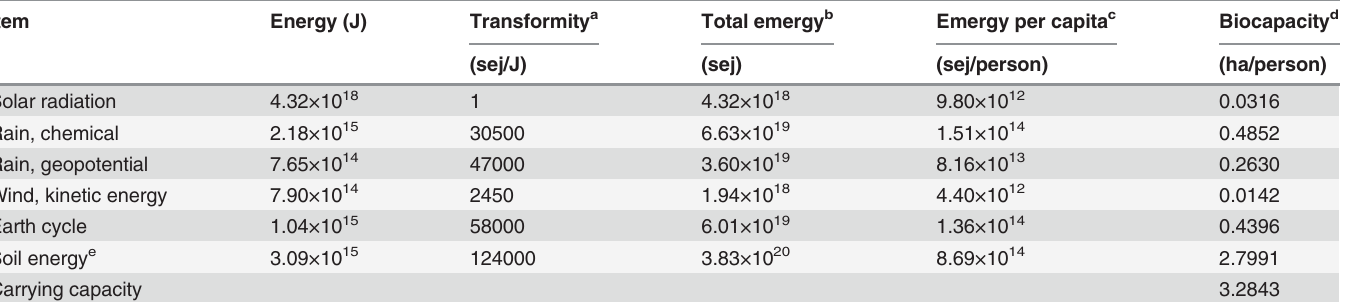
Table 1. Calculation of 2009 biocapacity for Yuanzhou County, Ningxia Hui Autonomous Region, China, using the EEF approach.